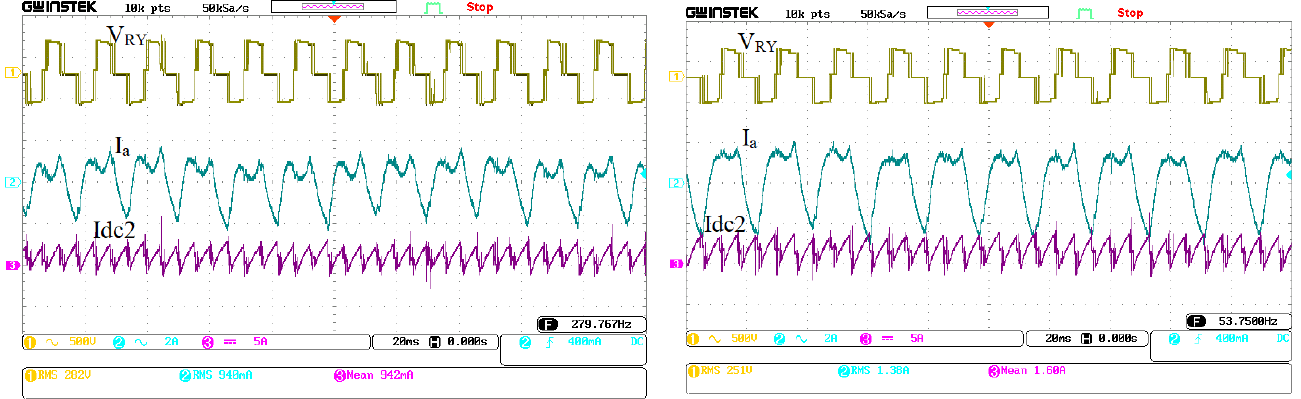
Figure 12. Experimental voltage, ac input current, and dc output current at low speed and maximum speed when power is supplied through the supplementary source.